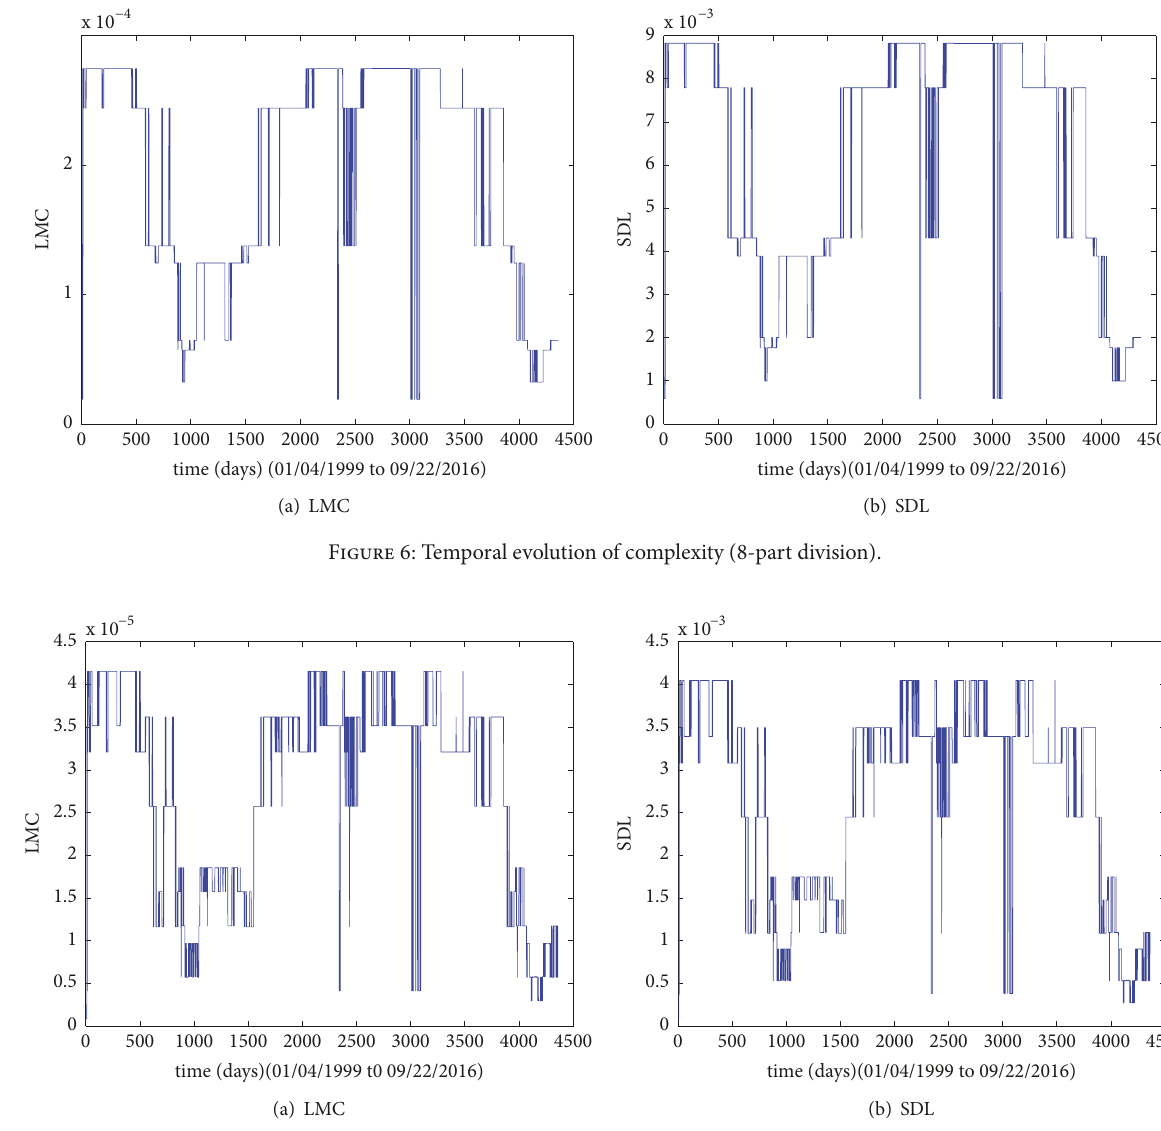
Figure 7: Temporal evolution of complexity (16-part